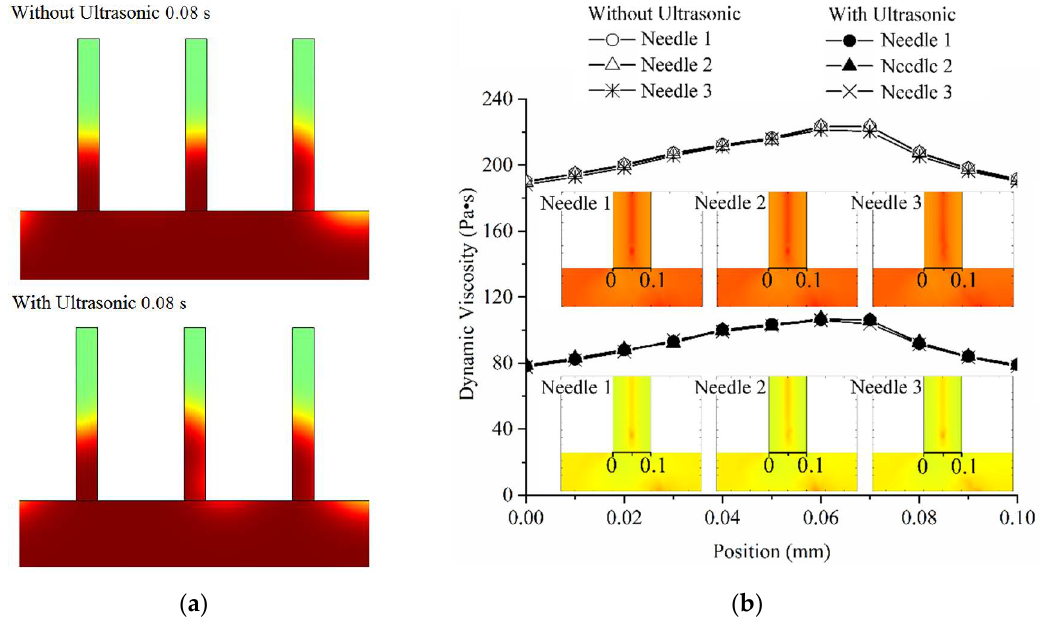
Figure 4. The melt filling and viscosity distribution of microneedle regions at 0.08 s with and without the effect of ultrasonic vibration: ( a ) the filling volume fraction of melt in micro-needle array cavity at 0.08 s with and without ultrasonic vibration, and ( b ) the melt viscosity distribution curves at the filling entrance transversal of microneedle regions with and without ultrasonic vibration.